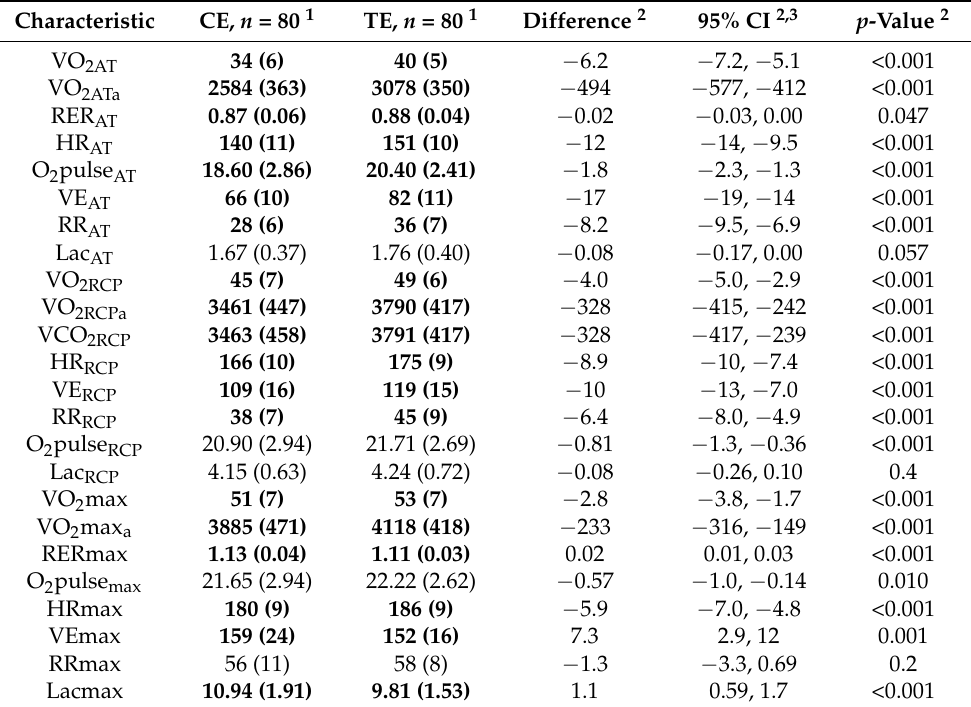
Table 5. Differences between cycle ergometry (CE) and treadmill (TE) CPET results in male participants ≤ 40 years; significant results are bold.